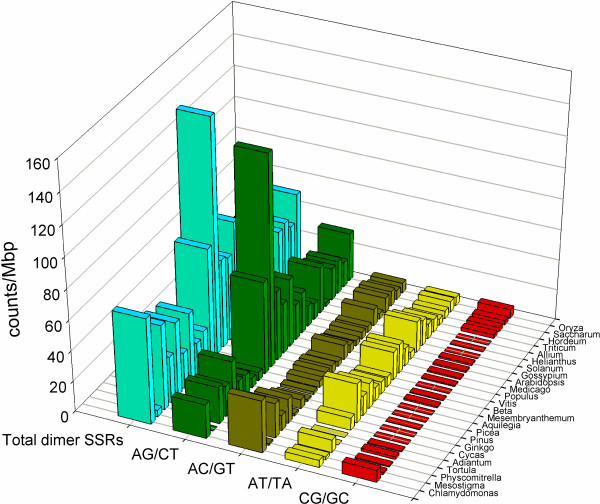
Frequencies of dimer microsatellite motifs among the gene indices of 24 plants. The microsatellite frequencies are calculated in SSR counts per megabase nucleotide information (counts/Mbp) as detected in the gene indices of 24 phylogenetically well distributed plant species. The total dimer SSR frequency is further subclassified into the four canonical non-redundant motifs (see also Additional file 3).